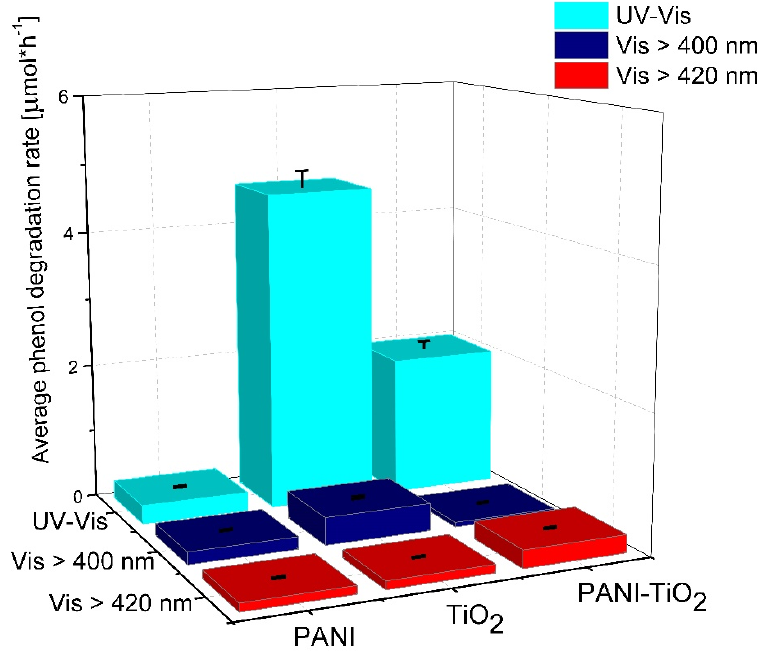
Figure 8. Phenol degradation of pure TiO 2 , PANI, and PANI–TiO 2 nanocomposite under UV-Vis, Vis ( > 400 nm) and Vis ( > 420 nm). Irradiation time: 60 min; photocatalysts loading: 2 g · dm − 3 ; phenol initial concentration: 20 mg · dm − 3 ; irradiation source: xenon lamp with cut-off filters .